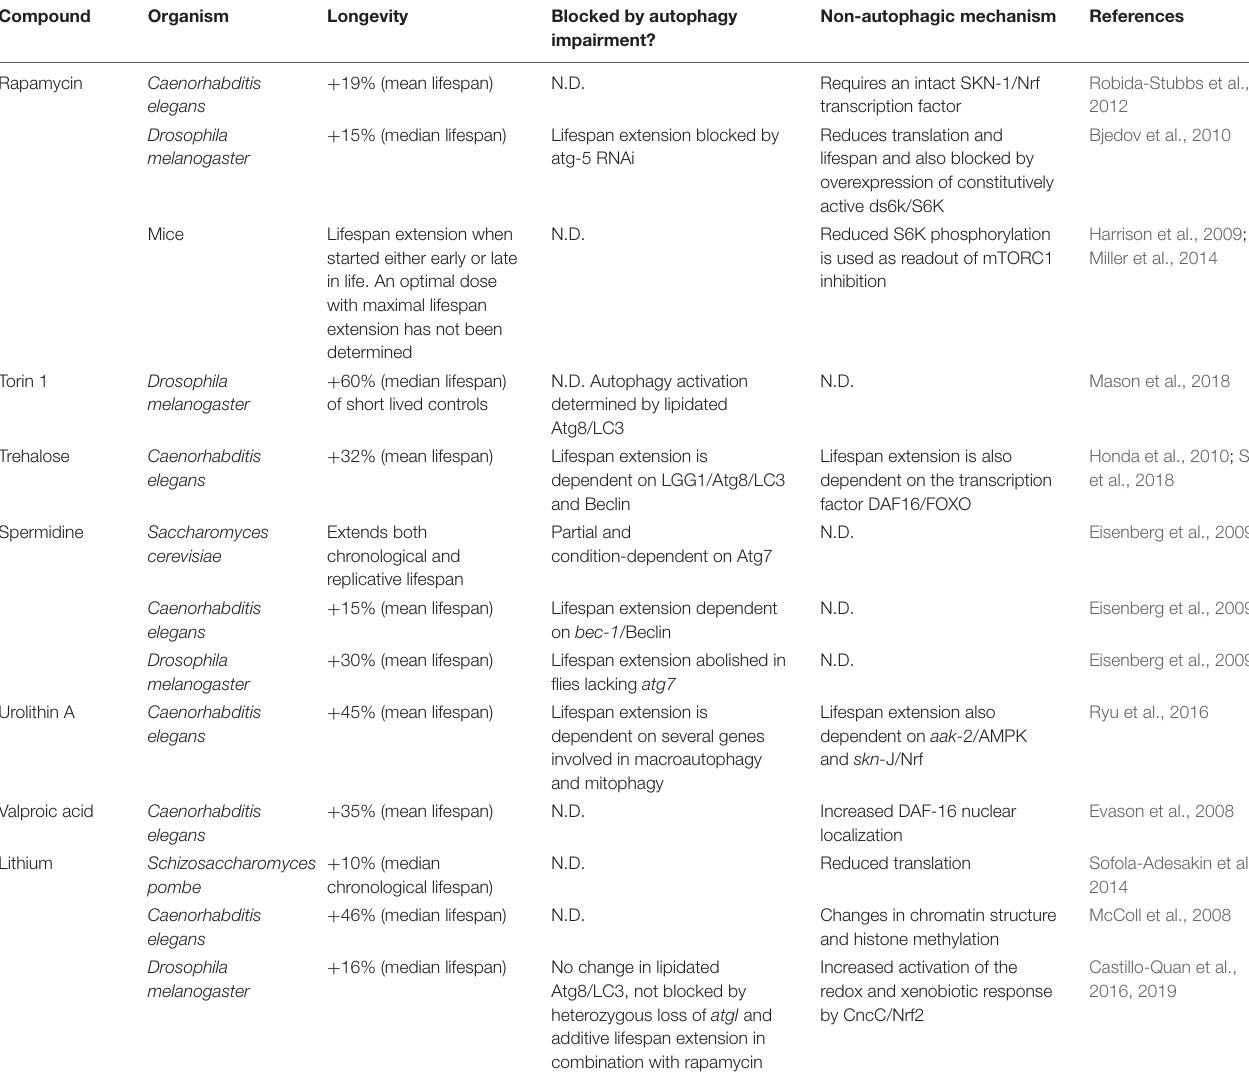
TABLE 2 | Compounds that increase autophagy with potential anti-ageing